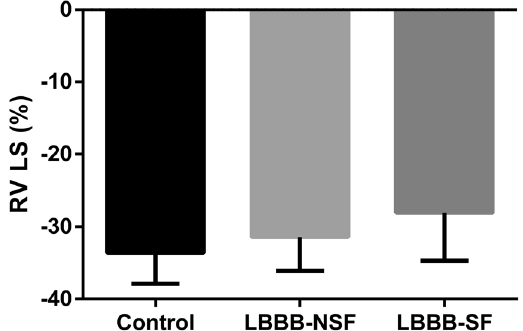
Figure 3. Effect of SF on RV LS. Note that RV LS of the LBBB-SF patients was significantly lower than the LBBB-NSF patients and controls. SF, septal flash; RV, right ventricle; LS, longitudinal